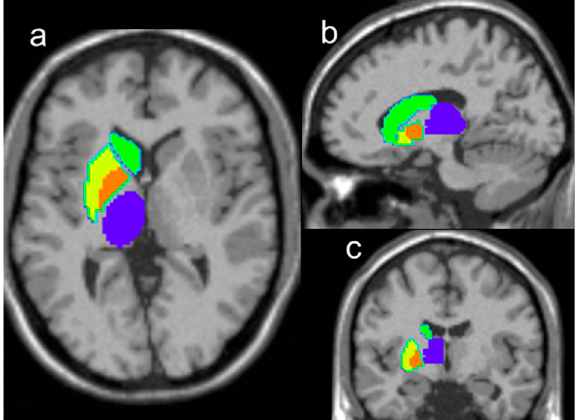
Figure 1. Illustration of the AAL ‐ atlas defined regions used for the analysis, including right caudate nucleus (green filled areas), putamen (yellow filled areas), pallidum (orange filled areas), and thalamus (blue filled areas), overlaid on T1 weighted images in traverse section ( a ), sagittal section ( b ), and coronal section ( c ), and corresponding regions in the left hemisphere (without colored marker).